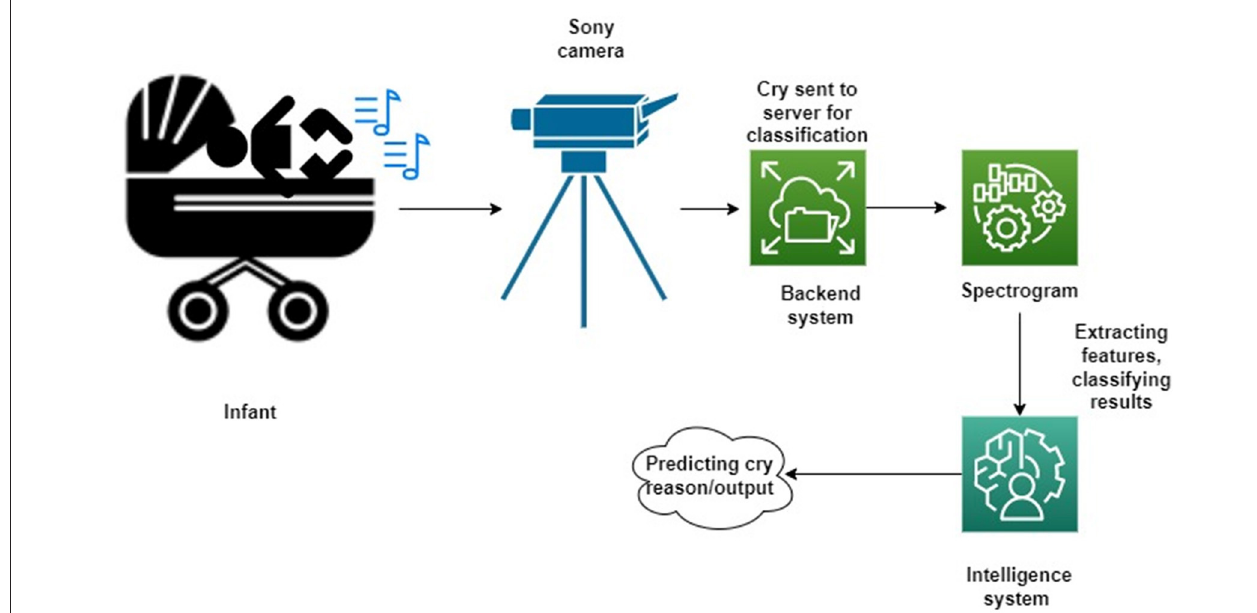
FIGURE 3 | Audio signal of a sample baby cry.